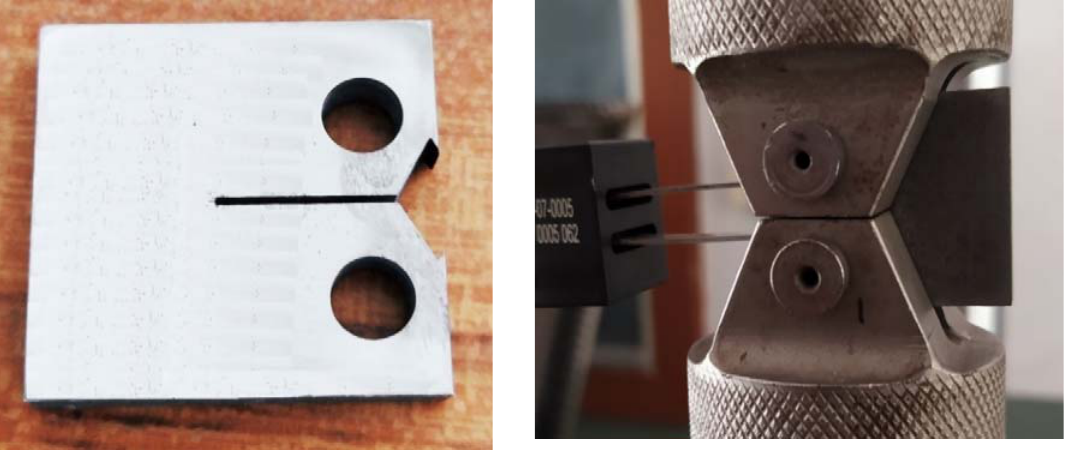
Figure 1 (b): experimental